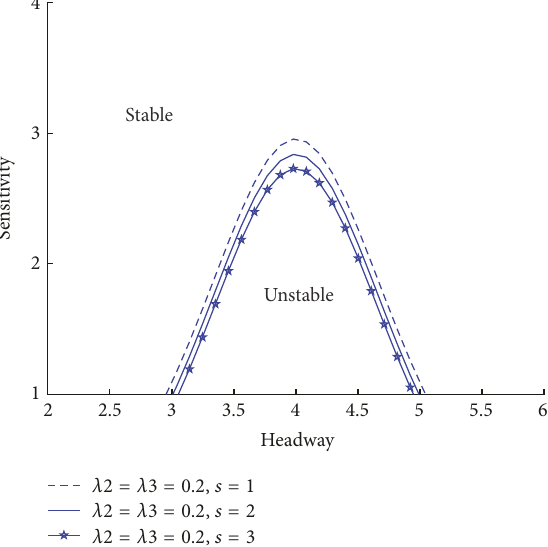
Figure 4: Different stable curves with different car numbers on the two adjacent lanes in LVRD